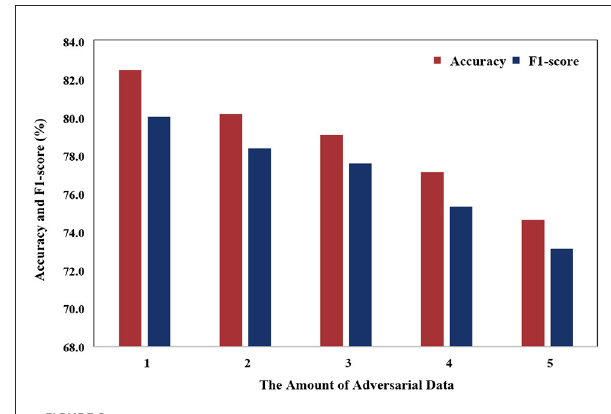
FIGURE8 Comparing performance with varying numbers of adversarial